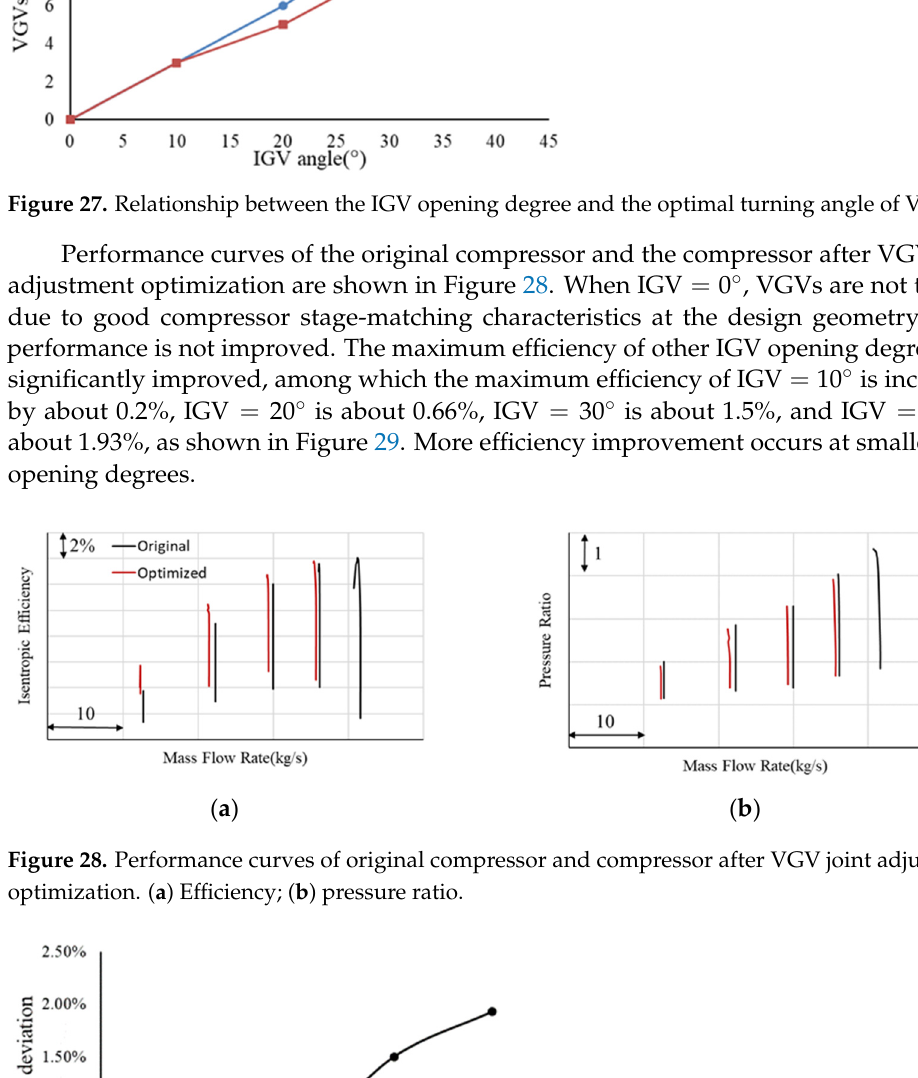
Table 1. Optimal joint turning angles of VGVs.